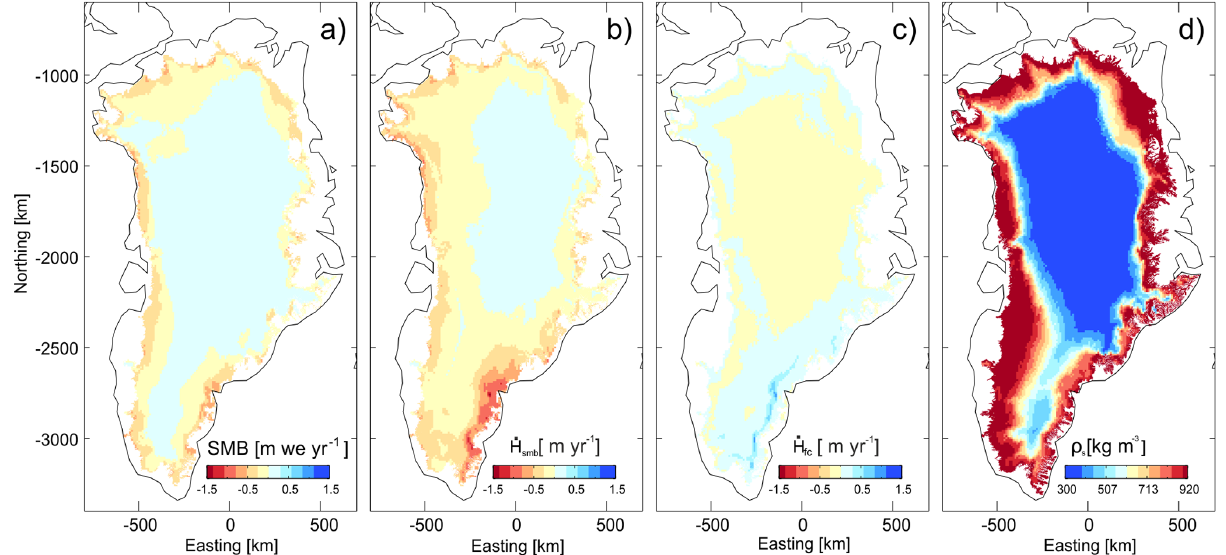
Figure 4. SMB (a) ; d H /d t caused by SMB variability: ˙ H smb (b) ; d H /d t caused by firn compaction: ˙ H fc (c) ; and ρ s (d) , as simulated by the firn model for 2003–2009.